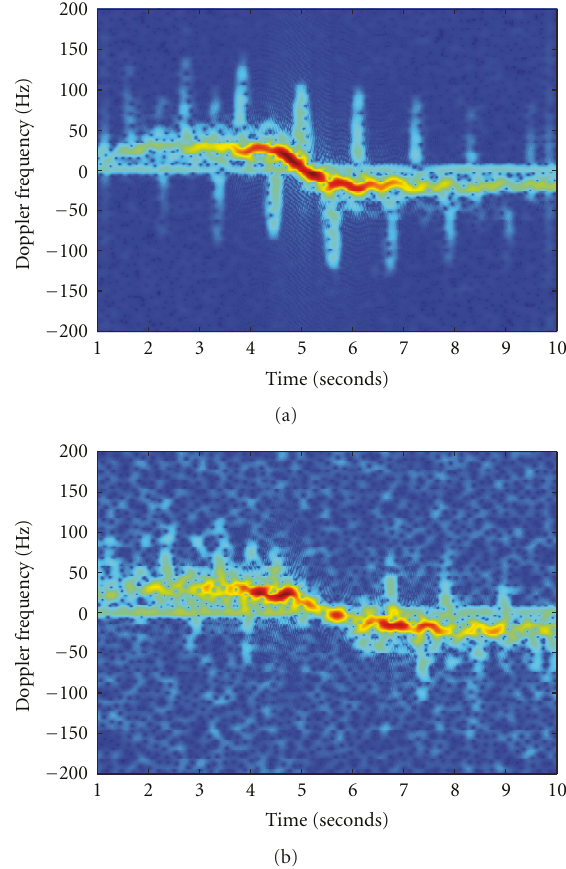
Figure 4: Doppler spectrograms of one-arm swing for a subject moving at: (a) 0 ◦ and (b) 30 ◦ with respect to the line of sight of the radar for the first 10 seconds of the recorded signal.